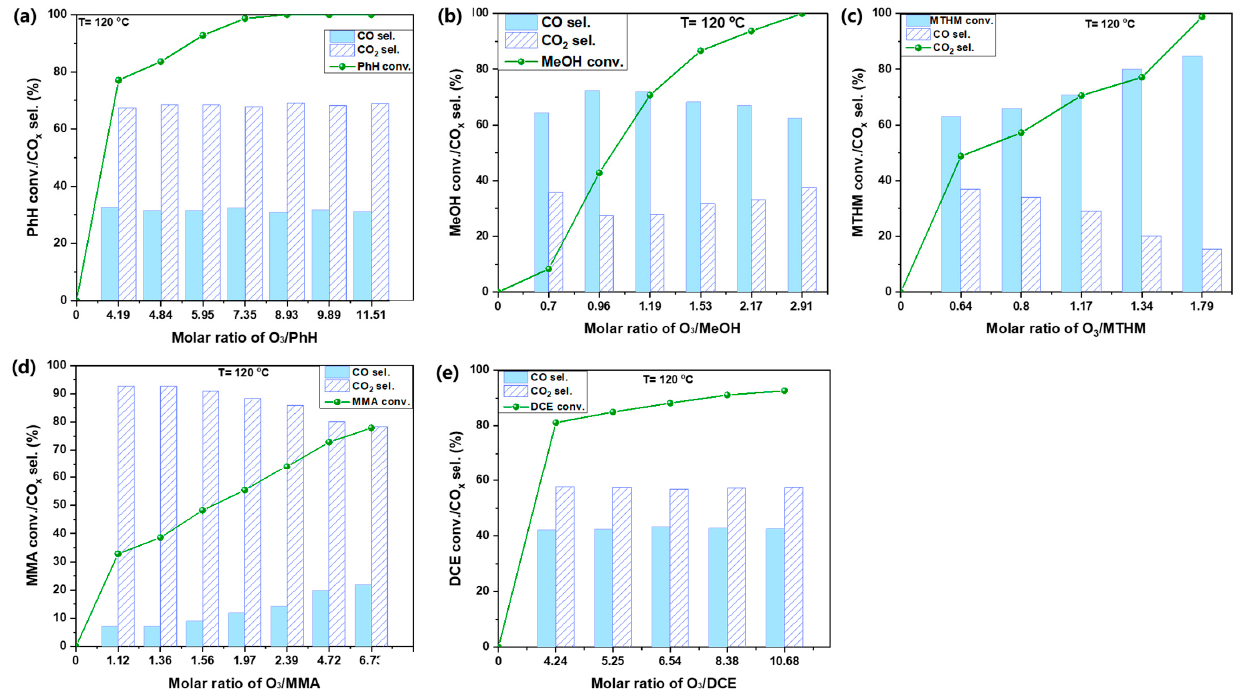
Figure 8. Catalytic ozonation of multitype VOCs with the optimal catalyst ( a ) PhH; ( b ) MeOH; ( c ) ( c ) MTHM; ( d ) MMA; and ( e ) MTHM; ( d ) MMA; and ( e ) DCE.